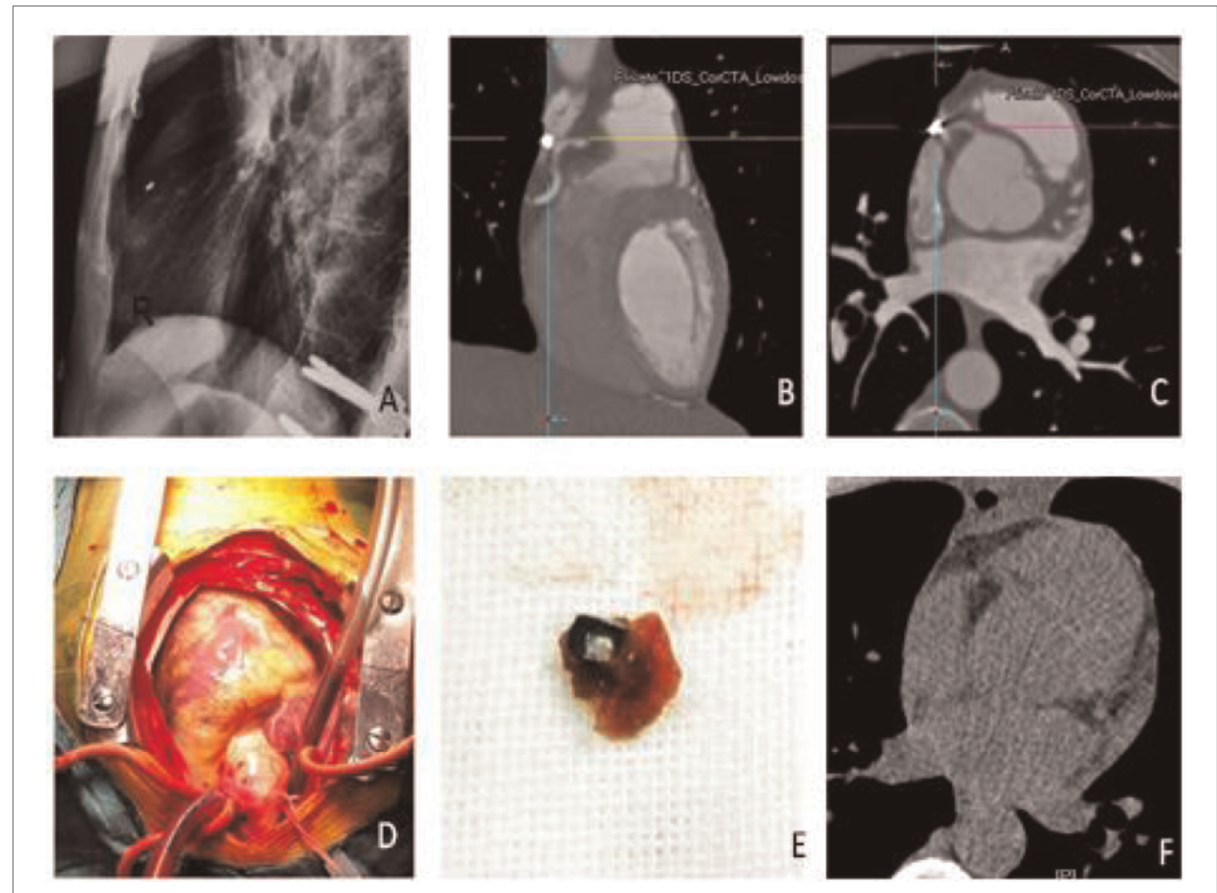
FIGURE 4 Radiation and dual-source CTA showed that the rongeur tip was in the auricula dextra ( A – C ). The tip was found in the auricula dextra close to the right atrioventricular groove ( D ). Image of the extracted rongeur tip ( E ). CT was used to con fi rm ( F ).